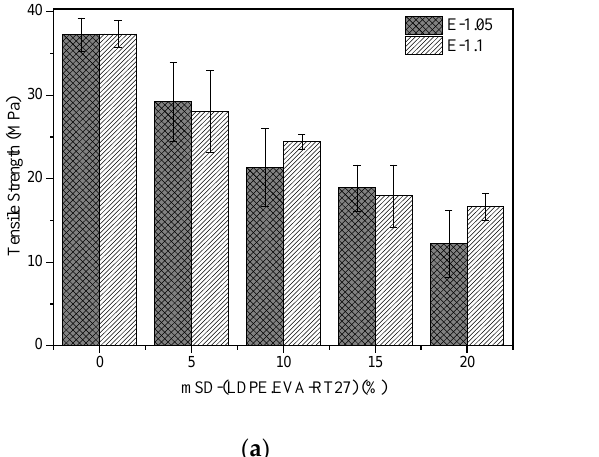
( b ) Figure 9. Resilience ( a ) and Shore A hardness ( b ) of the elastomers with mSD-(LDPE·EVA-RT27). According to the experimental results, the presence of the microcapsules improved the resilience of the elastomers, especially for the case of E-1.05. Nevertheless, the resili- ence of elastomer E-1.1 was always better than that observed for elastomer E-1.05. It is worth mentioning that the maximum resilience was found independently of the [NCO]/[OH] molar ratio for an mSD-(LDPE·EVA-RT27) content of 5 wt.%.